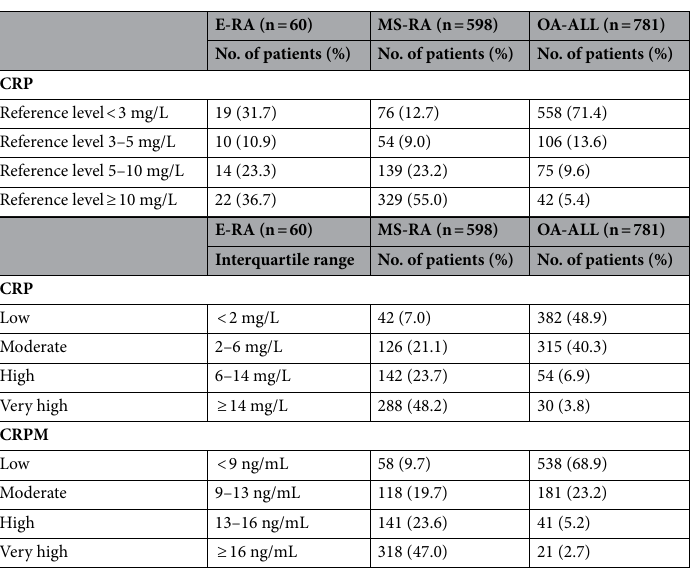
Table 4. Defining exploratory cut-off for low to very high levels of CRPM and